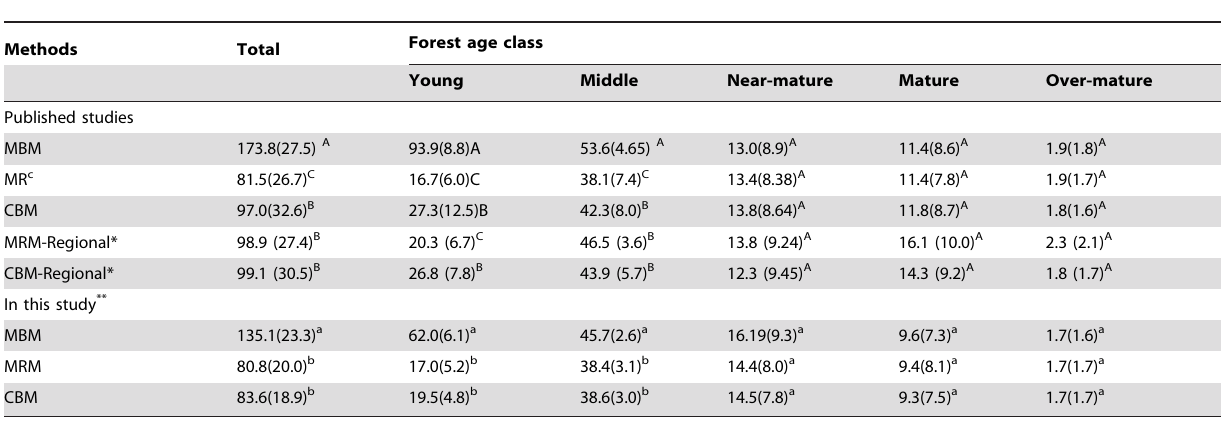
Table 4. Average estimates of forest biomass carbon storage (TgC) utilizing three calculation methods for equation parameters based on data from 2 nd –8 th National Forest